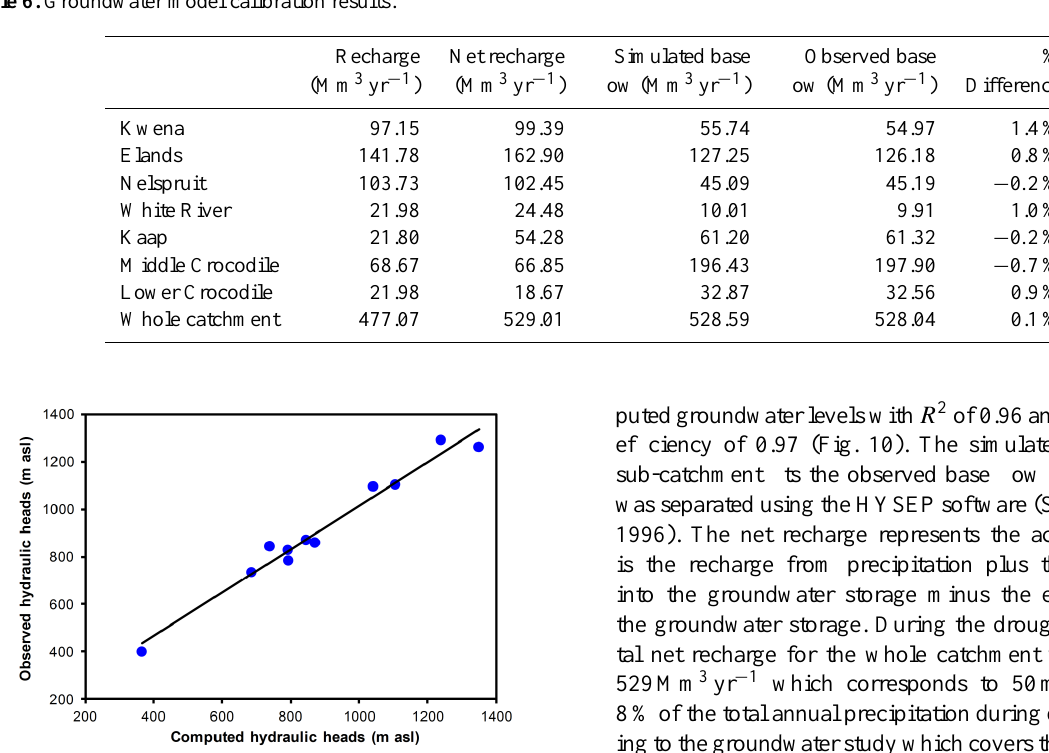
Table 6. Groundwater model calibration results.